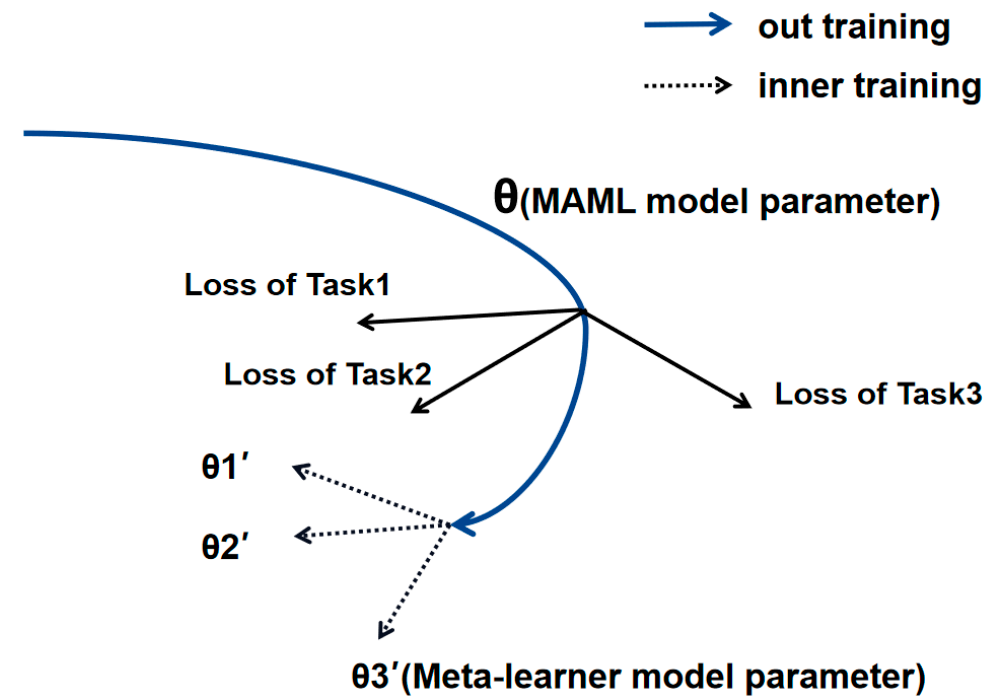
Figure 3. Two-layer parameter update of MAML model.